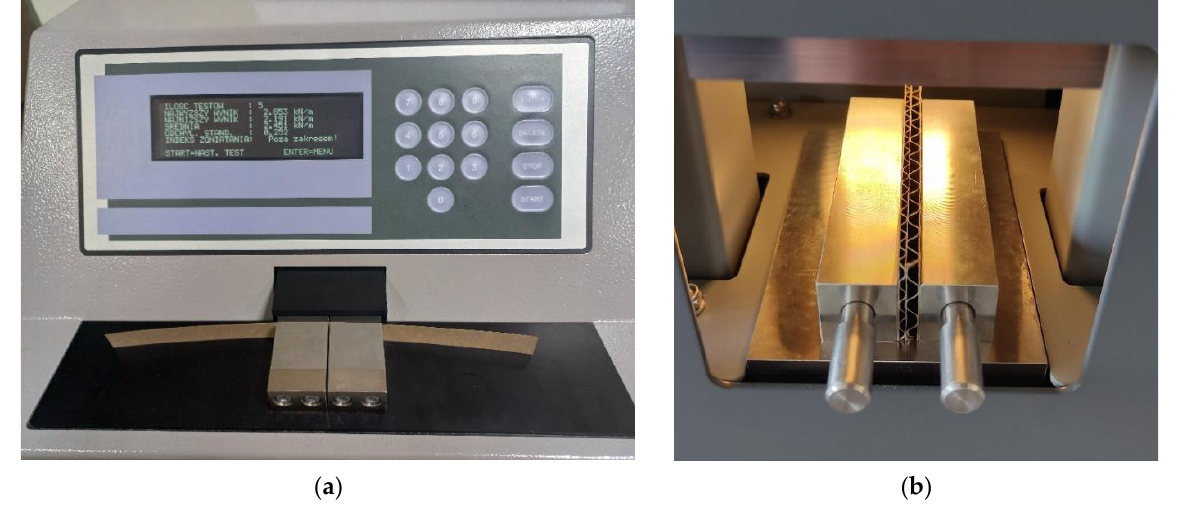
Figure 2. Laboratory testing machines: ( a ) short-span compression tester; ( b ) edge crush tester.